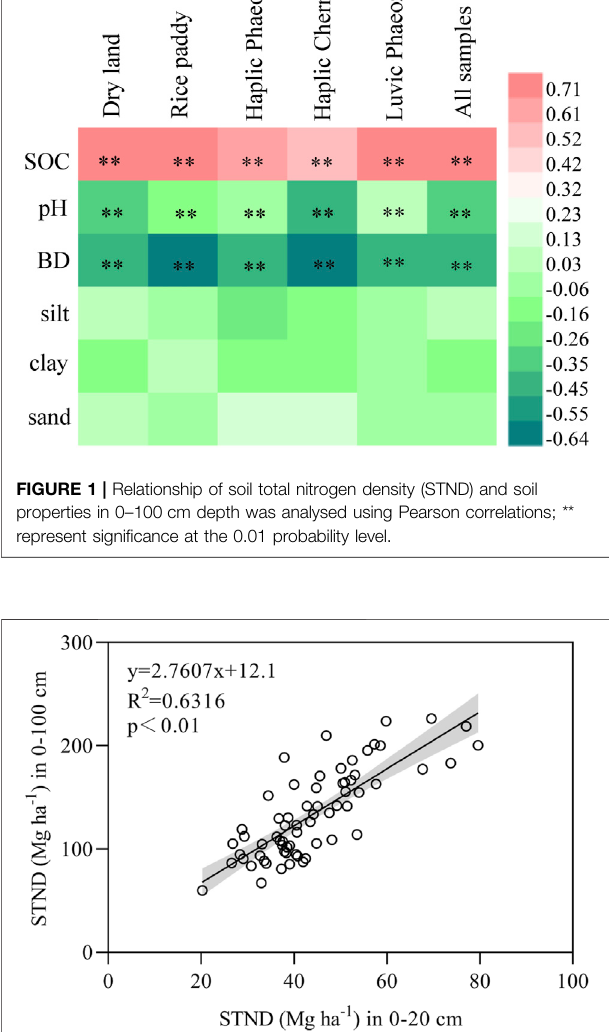
Frontiers in Environmental Science |